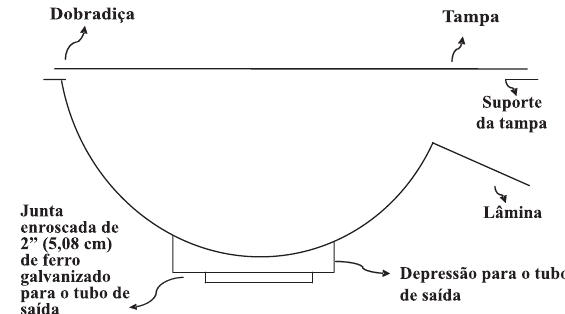
Figura 1. Dimensões da calha coletora de sedimentos utilizada nos tratamentos SV, P1 e P4 na região da Serra da Lua, Bonfim, norte do Estado de Roraima (Gerlach,